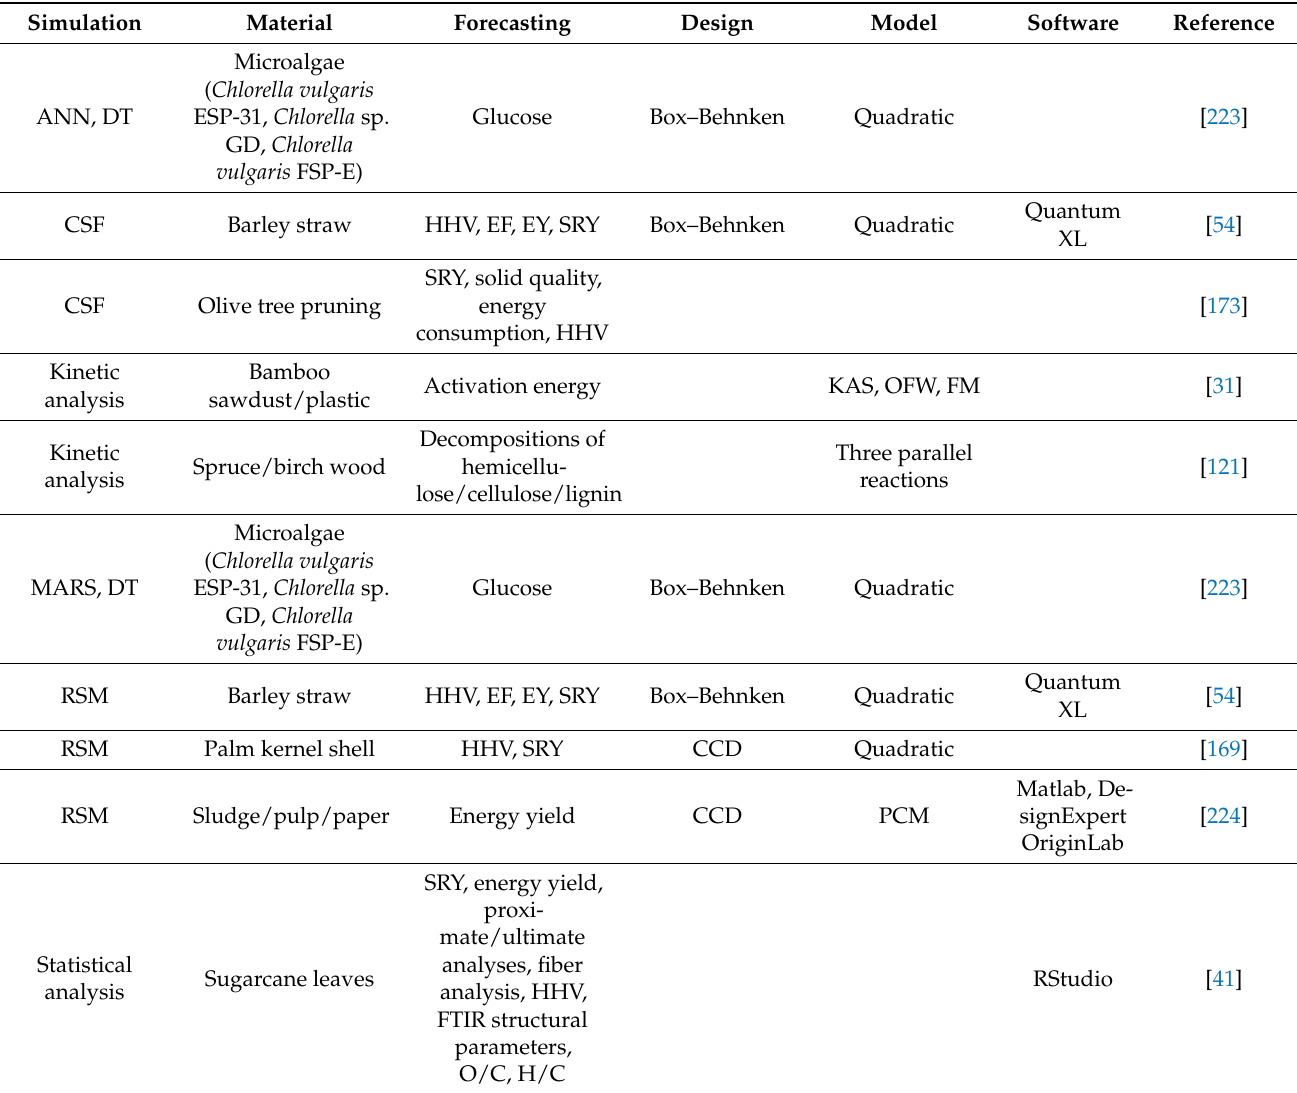
Table 8. Simulation of lignocellulosic biomass wet torrefaction